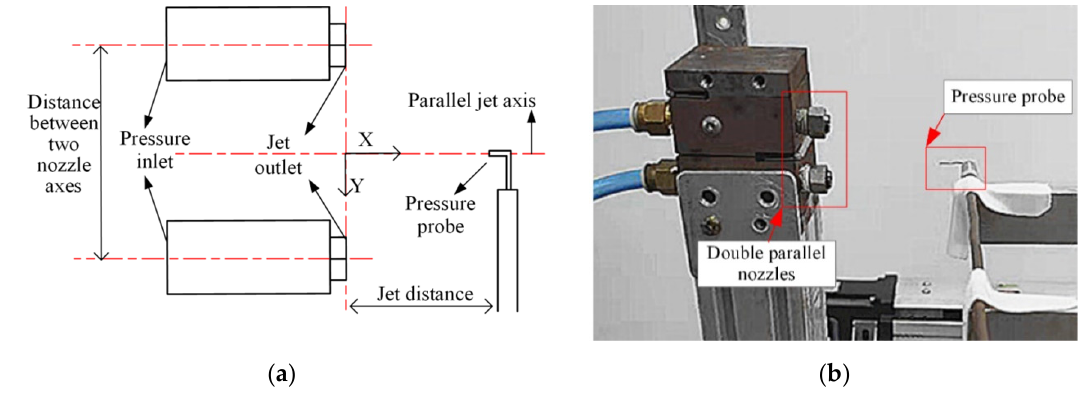
Figure 10. Experimental test system.